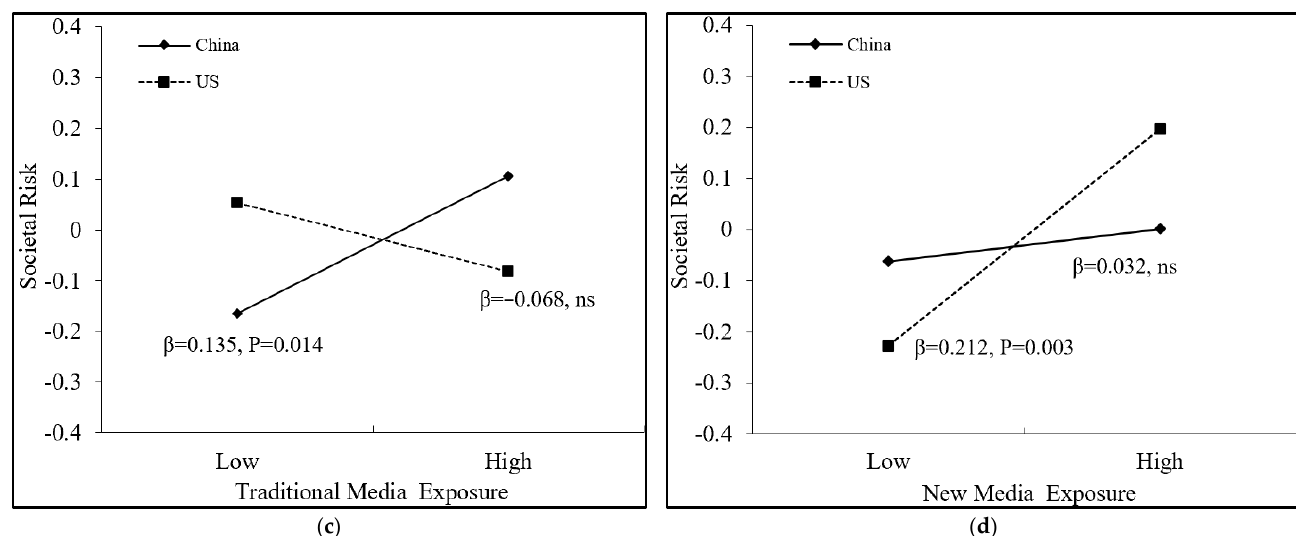
Figure 3. The moderating role of nationality in the association between different communication channels and self–other risk perceptions. ( a ) Nationality moderated the relation between interpersonal communication and personal risk perception; ( b ) Nationality moderated the relation between interpersonal communication and societal risk perception; ( c ) Nationality moderated the relation between traditional media exposure and societal risk perception; ( d ) Nationality moderated the relation between new media exposure and societal risk perception. Note. ns = non-significance.